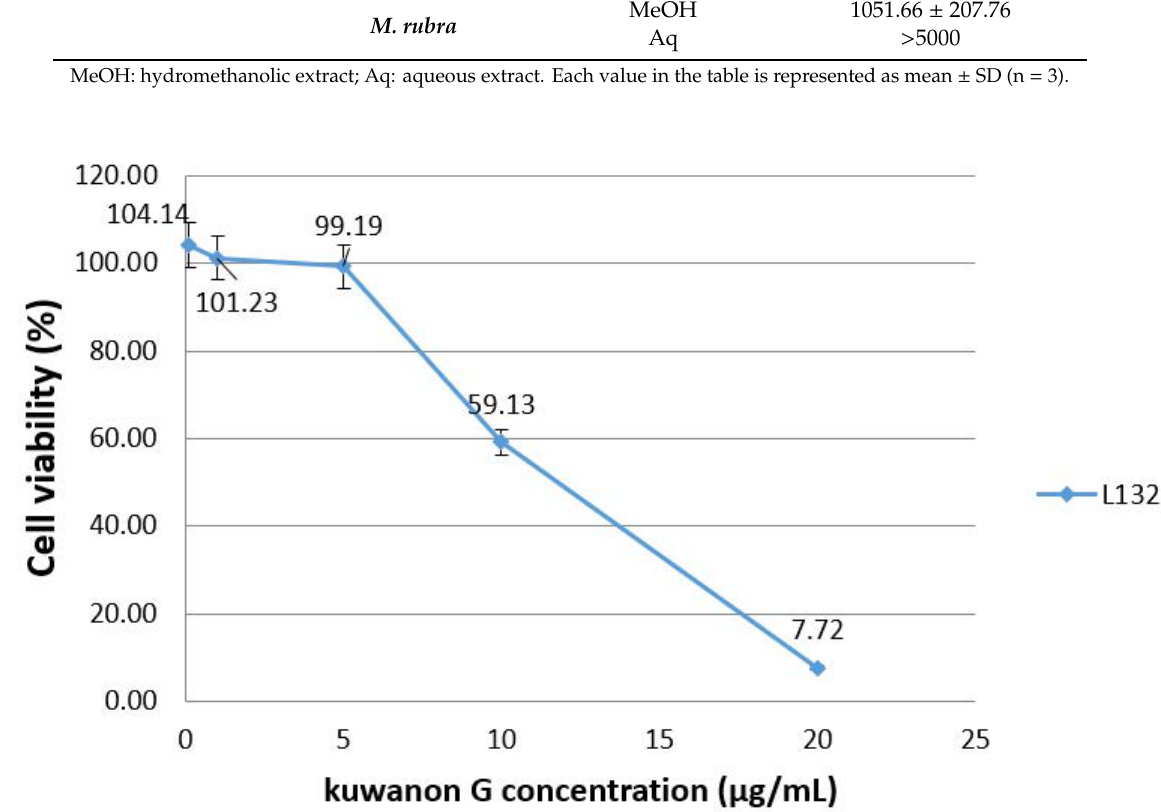
Figure 1. Cytotoxicity of kuwanon G on L-132 cell at 72 h